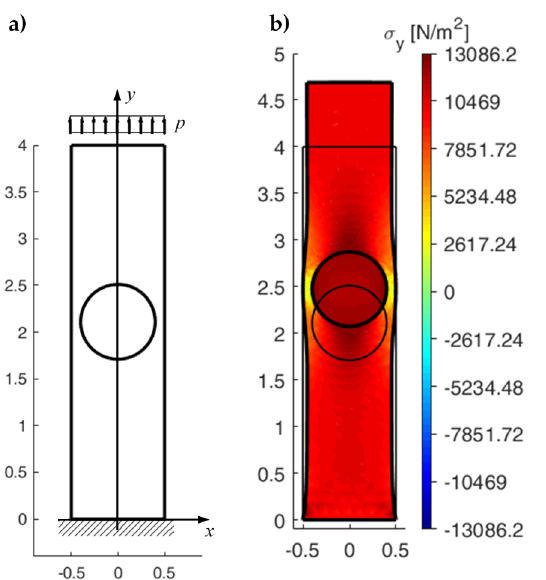
Figure 14. Geometry of a two-dimensional domain consisting of one row of three square elements (linear measurements in mm).